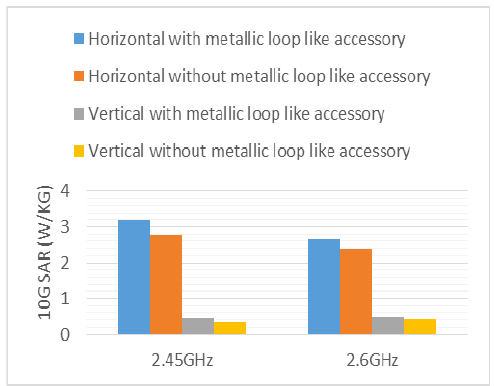
Figure 9: The effect of metallic loop like accessory 20 mm distance on 10g SAR at 2.45 GHz and 2.6 GHz.